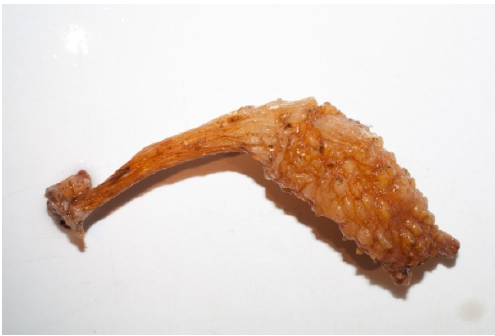
Figure 31. An image of Styela clava. © Claude Nozères (CC BY-NC-SA 4.0); http://www.marinespecies.org/.